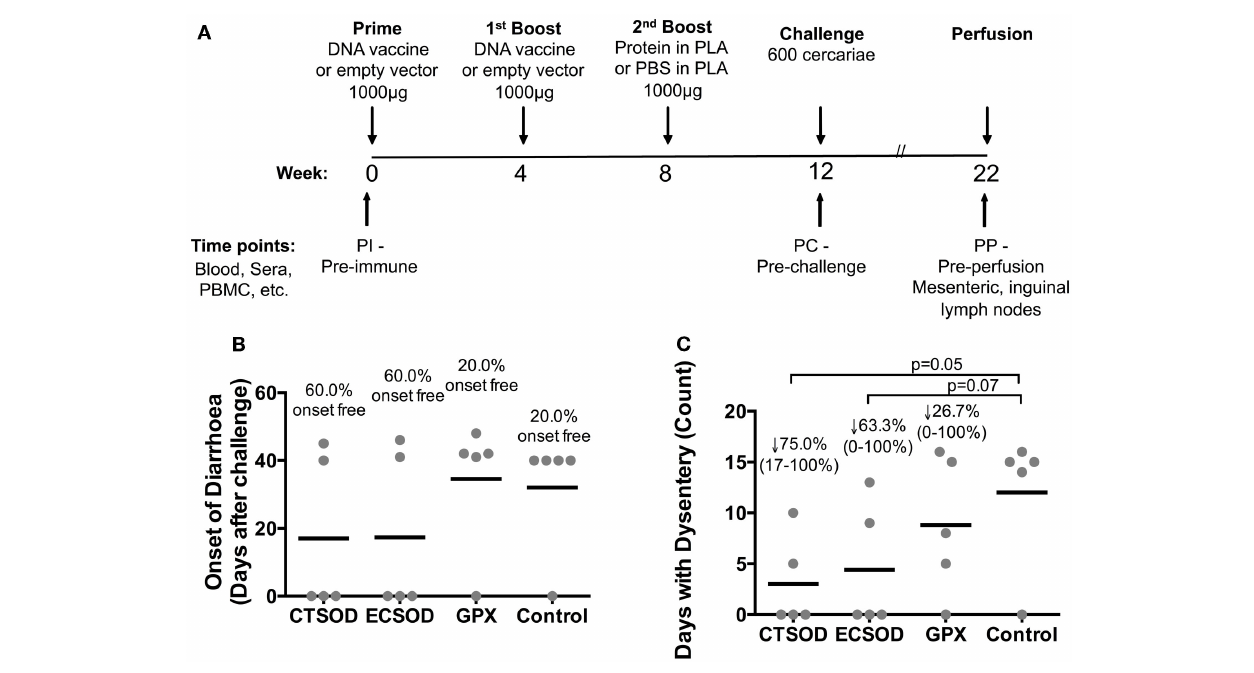
values (sphere); mean average (dash). The percentage of animals that did not suffer diarrhea is represented in (B) . In (c) , the percentage of reduction (represented by the arrow), the range (minimal-maximal, represented between brackets), and the statistical p -value were expressed in comparison to the mean average of the Control group. Non-parametric (Kruskal–Wallis, Mann– Whitney) tests were applied. Values were considered statistically significant when p <